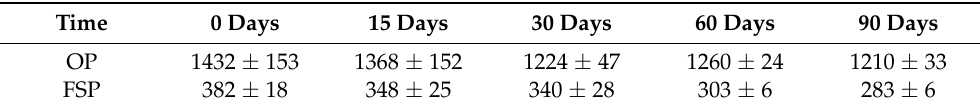
Table 1. SR content [ µ g/g d.w.] in lyophilized mixtures OP and FSP and its change during storage at room